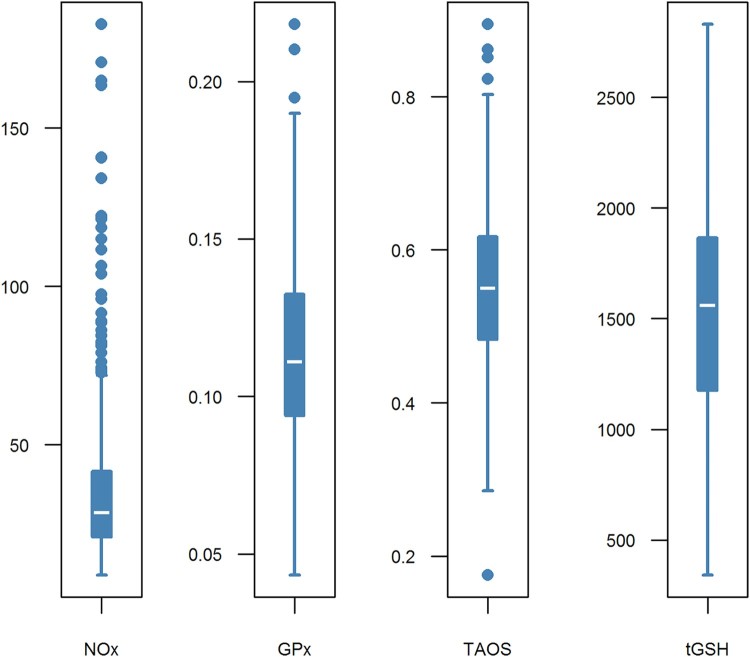
Box-whisker plots of the four redox parameters.
Abbreviations used: GPx: glutathione peroxidases [U/ml]; NOx:
nitrate/nitrite [µM]; TAOS: total antioxidant status [mM];
tGSH: total (reduced and oxidized) glutathione
[µM].